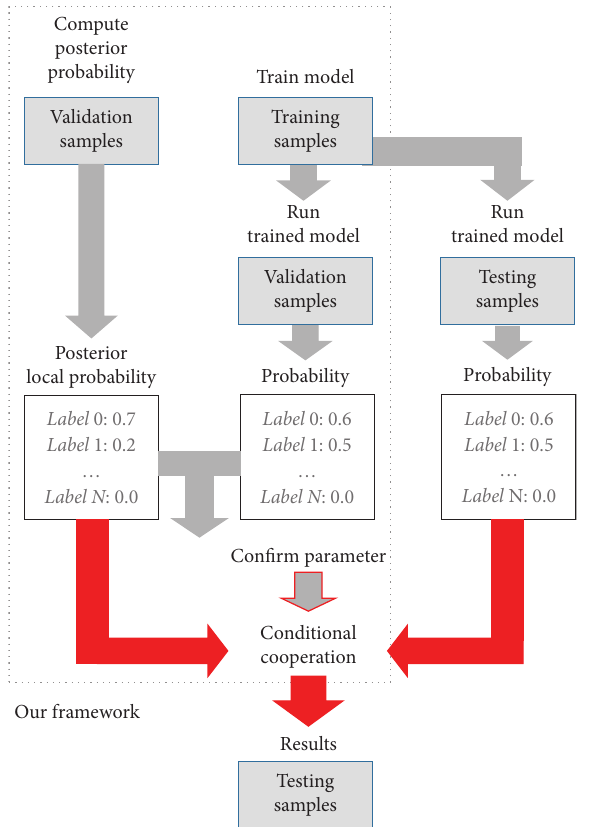
Figure 3: L-PDL, the framework of our